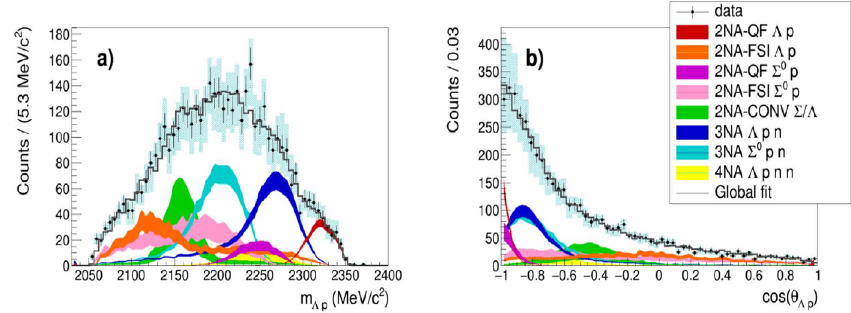
Figure 1. The Λ p invariant mass (panel a), Λ p angular correlation (panel b) distributions are shown for K − absorption on 12 C . Black points represent the data, black error bars correspond to the statistical er- rors, cyan error bars correspond to the systematic errors. The grey line distributions represent the global fit function, the coloured distributions represent the contributing processes according to the colour code reported in the legend and the widths correspond to the statistical error. The figure is adapted from Ref. [4].